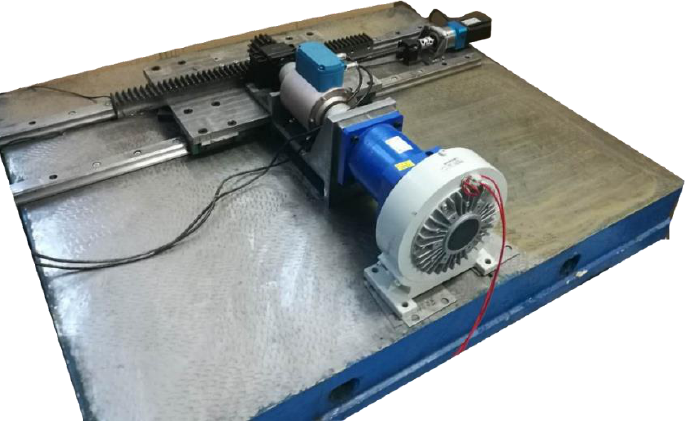
Figure 11. Test rig for ball screw fault diagnosis.